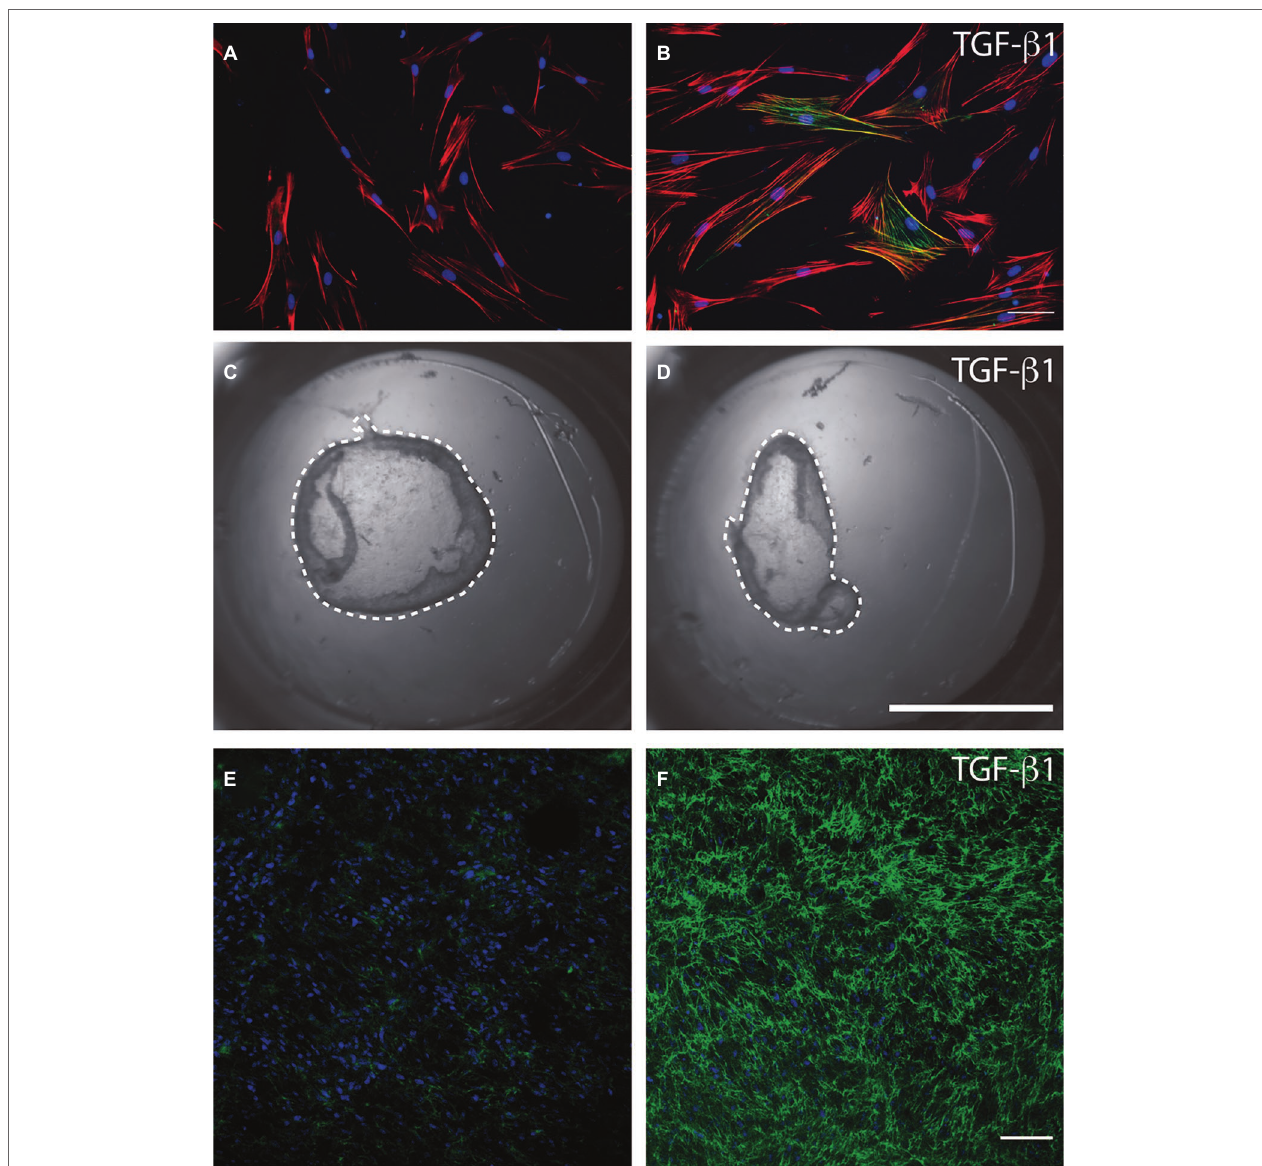
FIGURE 4 | Methods to study myofibroblasts in cell culture. Serum-starved human gingival fibroblasts were cultured over a type I collagen film (50 mg/ml) and stimulated or not (A) with recombinant transforming growth factor beta 1 (B) . Immunofluorescence was used to identify the actin cytoskeleton (red), cell nuclei (blue), and alpha smooth muscle actin (green). Magnification bar equals 20 microns. Human gingival fibroblasts were cultured within a type I collagen gel (1 mg/ml) in the presence of 1% fetal bovine serum with the addition or not (C) of transforming growth factor beta 1 (D) . After 24 h collagen gels were released from the borders of the cell culture dish using a fine needle and the contraction of the gel was registered photographically. Dotted line represents the periphery of the collagen gel that must be compared to the periphery of the original gel area (area of the culture dish). Human gingival fibroblasts cultured within collagen gels were stimulated, or not, with TGF-b1 (E and F) . Collagen gels were stained for fibronectin (green) and cell nuclei (blue) and analyzed through confocal microscopy. Images show that TGF-b1 strongly stimulated fibronectin protein levels. Magnification bar = 40 μ m. Images in this figure represent reanalysis of previously published data in Retamal et al.,